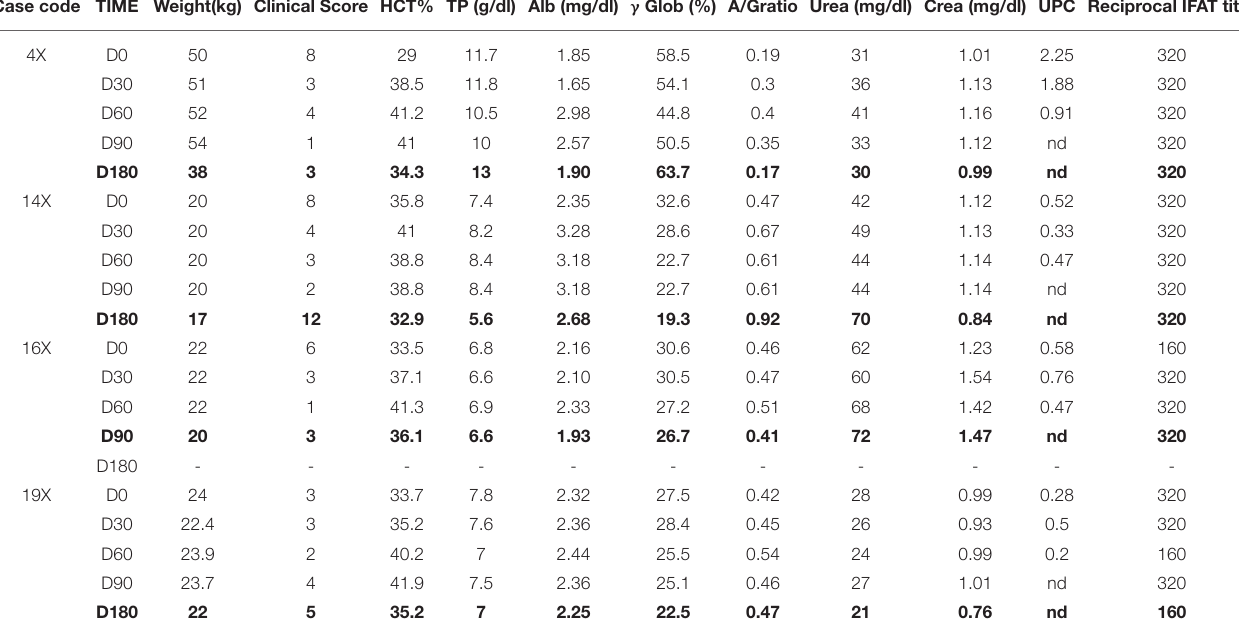
TABLE 4 | Clinicopathological parameters (bold values) of dogs showing relapses during the